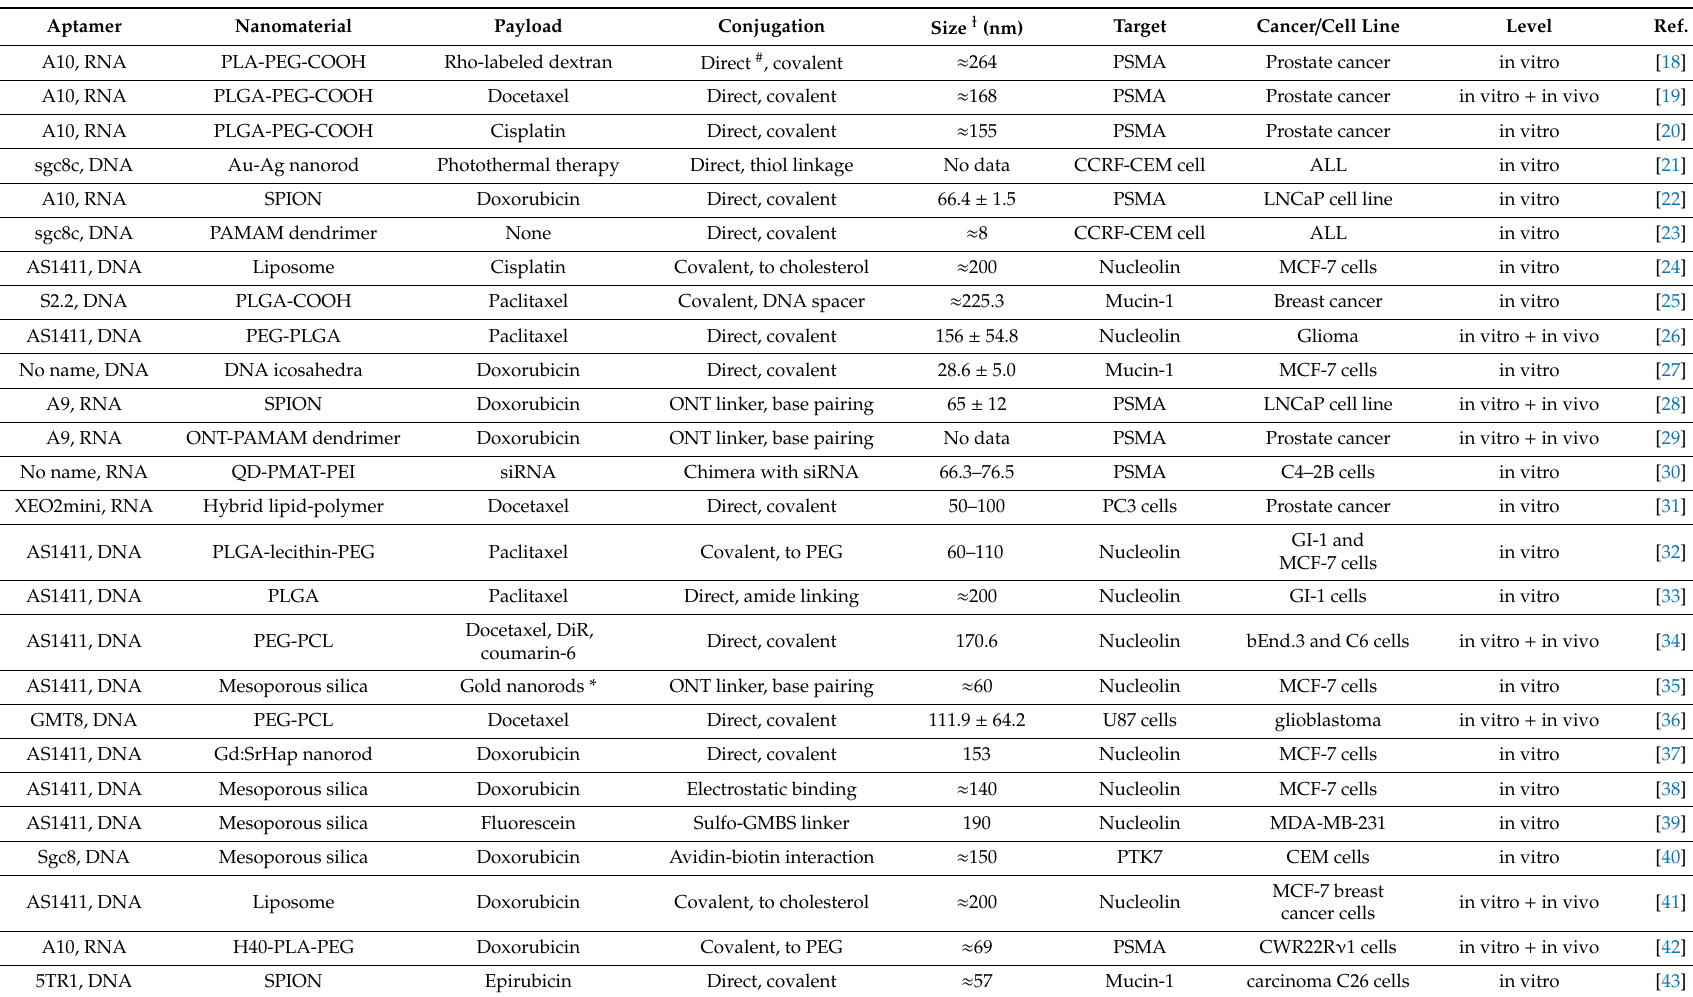
Table 1. Aptamer-functionalized nanoparticles designed for actively targeted drug delivery and cancer therapy in laboratory investigation